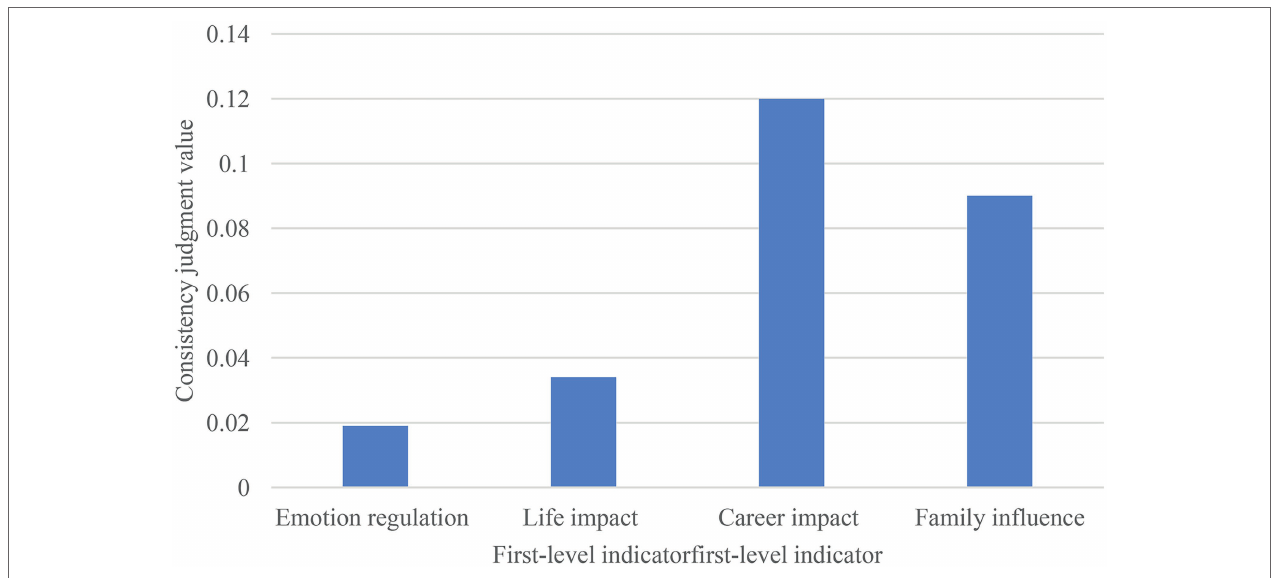
FIGURE 2 | Consistency judgment results.